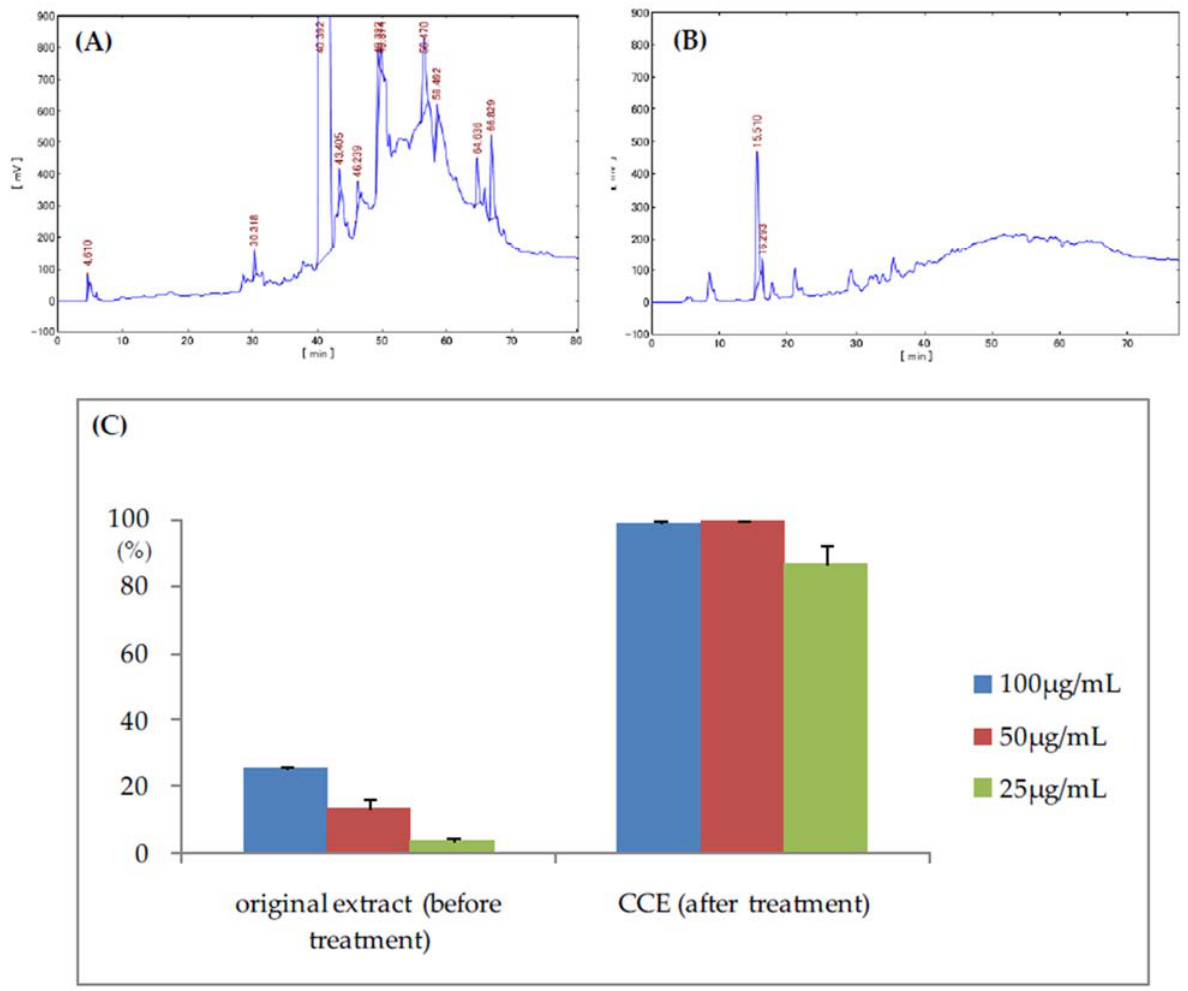
Figure 1. UV-HPLC profiles and anti- Leishmania major activity of A. galanga extract; ( A ) before ( B ) after treatment with dioxirane. HPLC: ODS, UV: 215 nm; ( C ) the percentage of inhibition against L. major before and after chemical treatment. The error bar represents SE, n = 3.